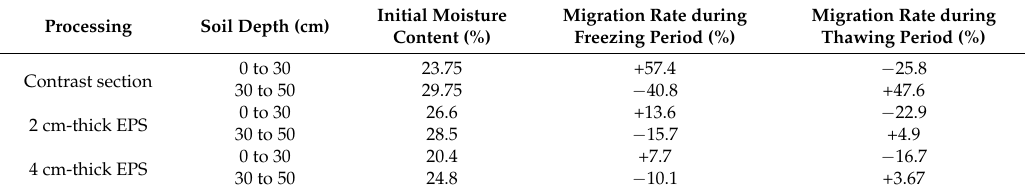
Table 6. Moisture changes in the 0 to 50 cm soil layers under the different EPS thicknesses. Processing Soil Depth (cm)